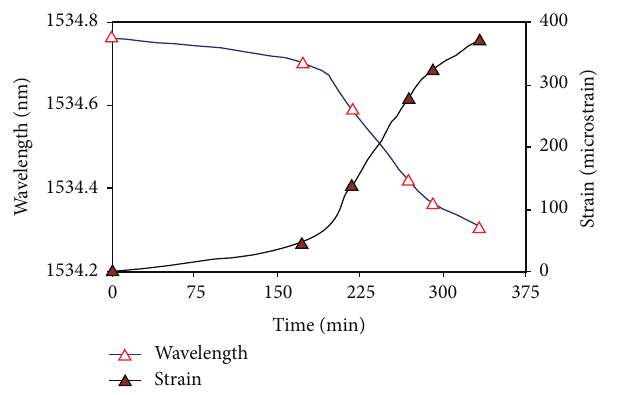
Figure 7: Wavelength shifts as a function of strain